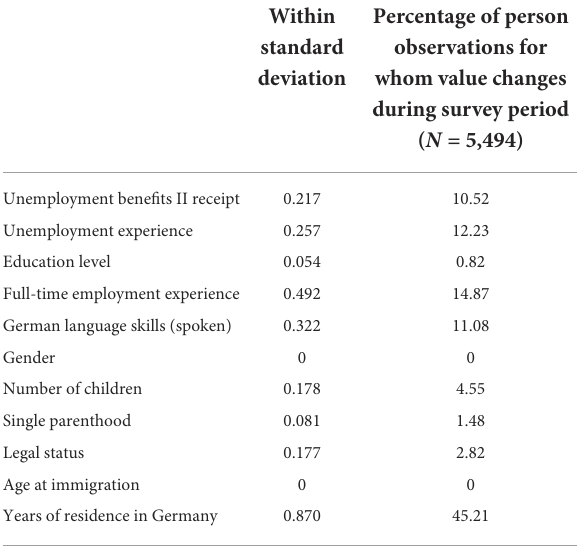
TABLE 2 Within variation of